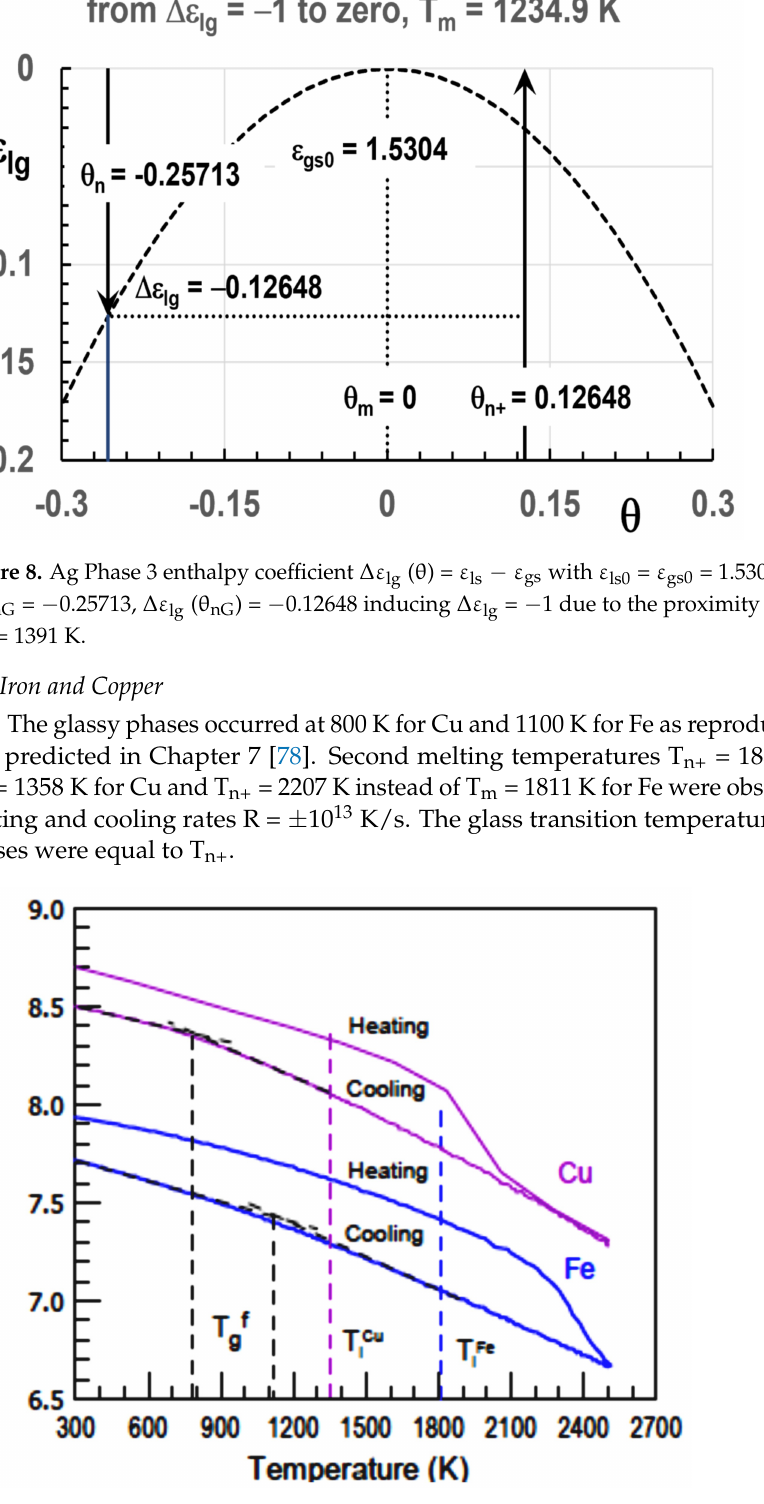
Figure 9. MD simulations of liquid copper density observing a melting temperature of 1839 K instead of T m = 1358 K and MD simulations of liquid iron density observing a melting temperature of 2207 K instead of T m = 1811 K. R = ± 10 13 K/s. Reprinted with permission from Ref.